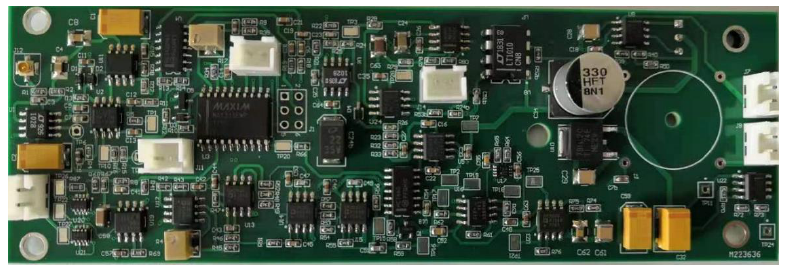
Figure 9. Photo of the electronic unit.